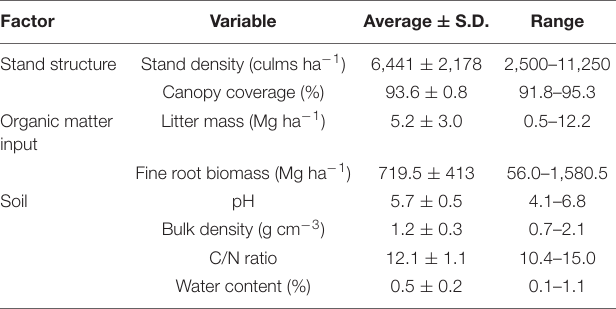
TABLE 2 | Description of factors and measured variables used in the structural equation models and the linear-mixed